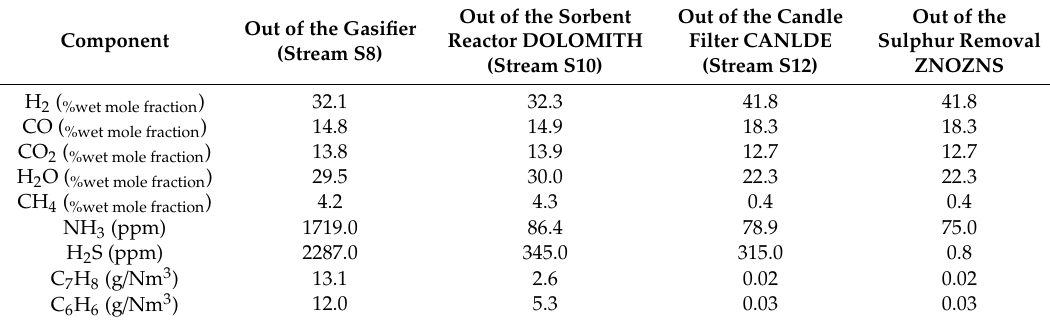
Table 5. Composition of the